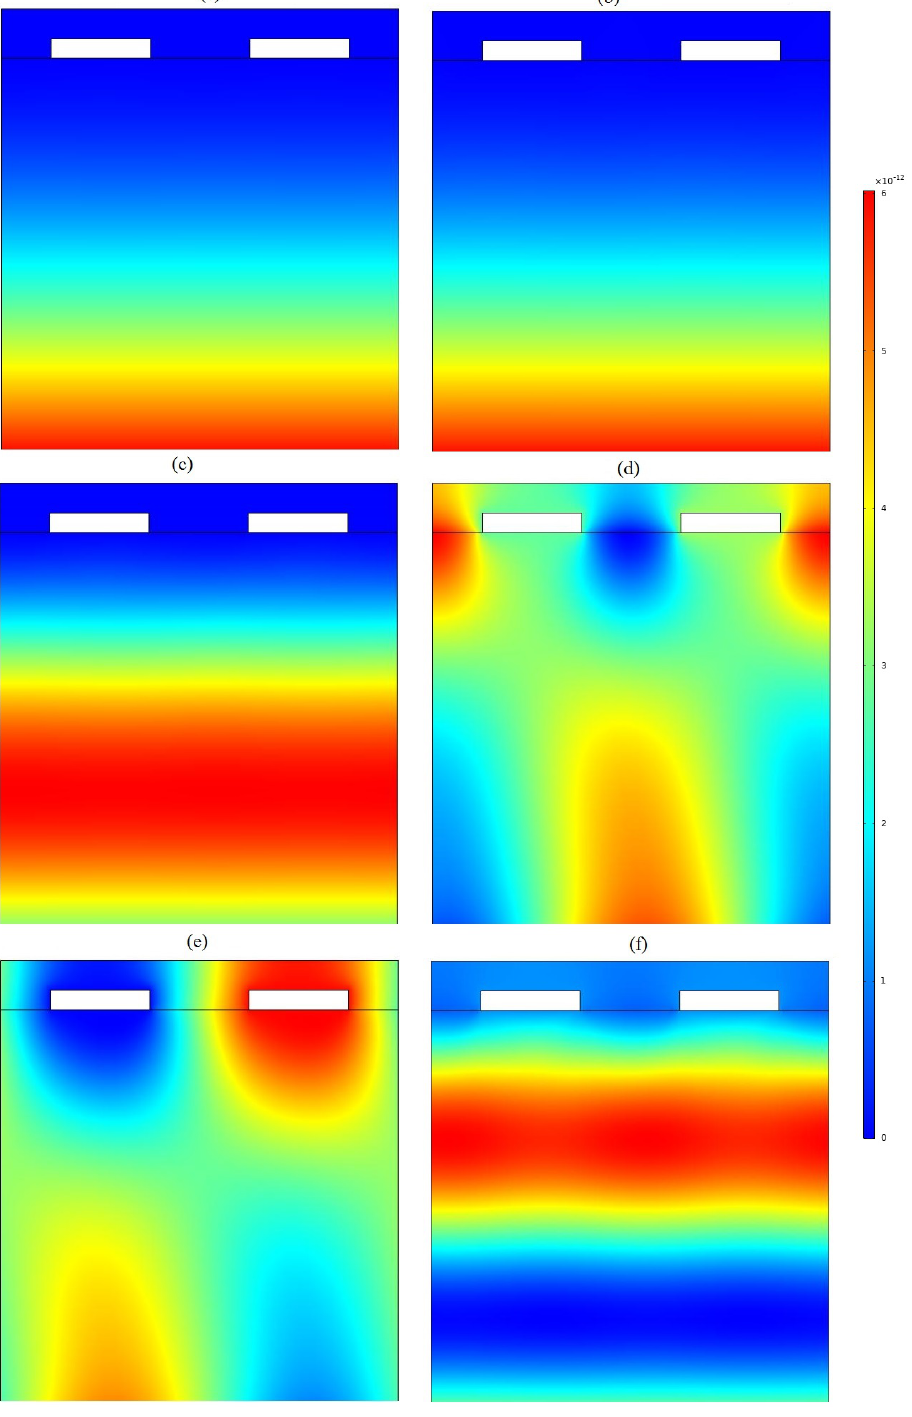
Figure 5. Electric potential: ( a ) mode 1, ( b ) mode 2, ( c ) mode 3, ( d ) mode 4, ( e ) mode 5, ( f ) mode 6. The finite element method is used to solve problem. The relaxation factors for the velocity components, pressure correction, thermal energy, and liquid fraction were 0.5, 0.3, 1, and 0.9, respectively. To benchmark the problem, previous work of Jamalabadi and Park [18] is used. Jamalabadi and Park [18] applied the well-known software FLUENT to simulate the problem of melting in square cavity. The cavity of fluid at the right of the electric part is filled with nanofluid that is a mixture of an inorganic hydrated salt TH29 PCM [18] and solid copper nanoparticles. The TH29 is made by an inorganic